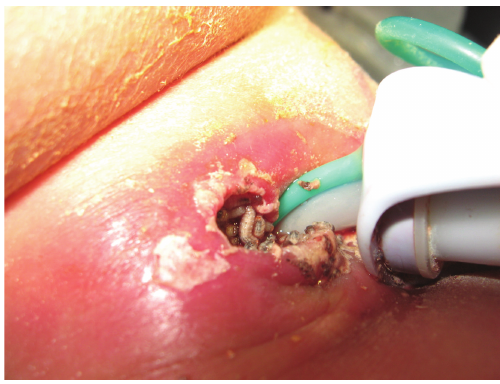
Figure 1: Tracheostomy wound